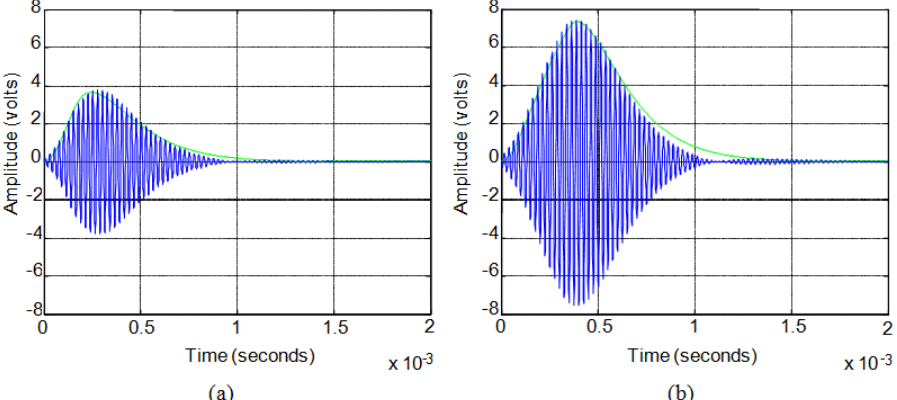
Figure 8. ( a ) Six-cycle pulse response; ( b ) Fourteen-cycle pulse